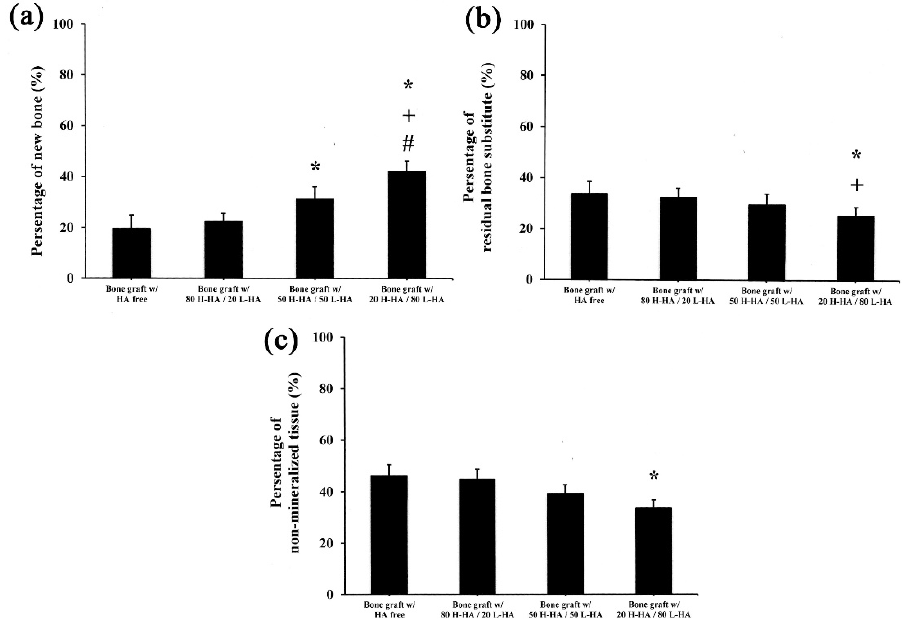
Figure 7. Statistical analysis of histological quantification of ( a ) new bone formation, ( b ) residual bone substitute and ( c ) non-mineralized tissue. Data are expressed as mean ± standard deviation. Symbols *, + and # denote significant differences ( p < 0.05) from the bone graft with HA free, bone graft with 80 H-HA/20 L-HA and bone graft with 50 H-HA/50 L-HA groups, respectively. Significance was determined using the post hoc Duncan test after one-way ANOVA.